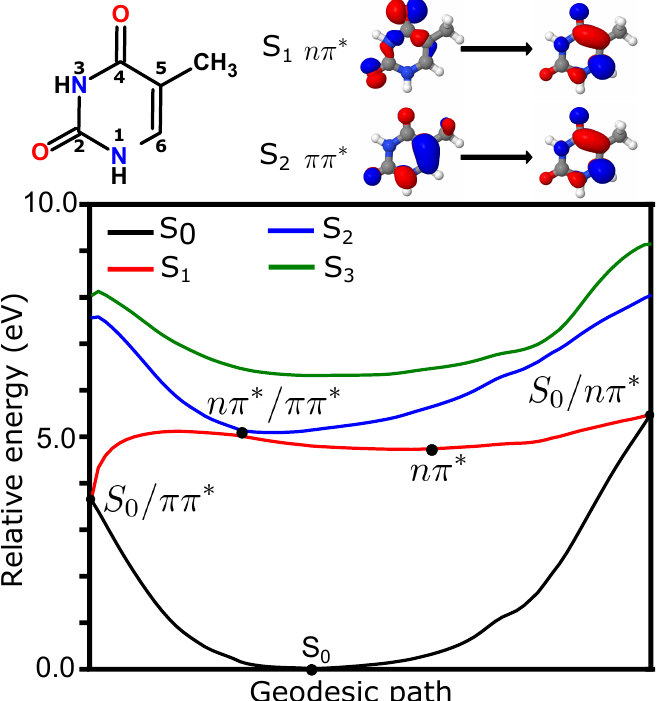
Figure 1. Photochemistry of thymine in the gas phase. ( top , left ) Schematic structure of thymine with atom numbering. ( top , right ) Main character of the transitions representing the first and second singlet excited states. ( bottom ) Geodesic path connecting the conical intersections between S 0 / n π ∗ , S 0 / ππ ∗ and n π ∗ / ππ ∗ as well as S 0 and n π ∗ minima. Energies (in eV) have been computed at the TDA-TDBH&HLYP/6-31G*